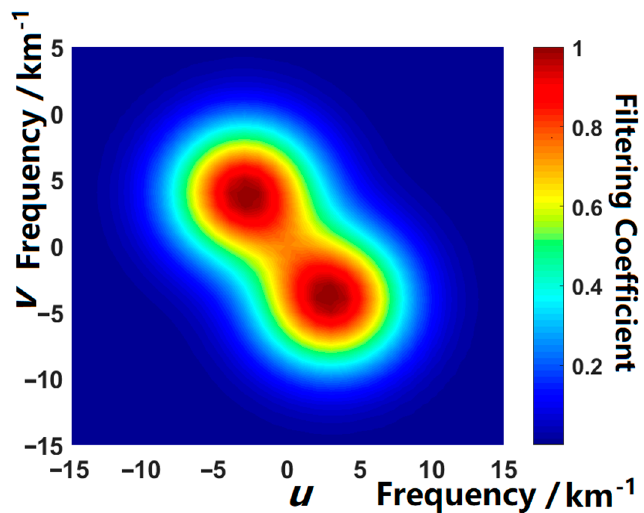
Figure 4. Filtering function. u and v are the zonal and meridional frequency, respectively. The color bar indicates the filtering coefficient.